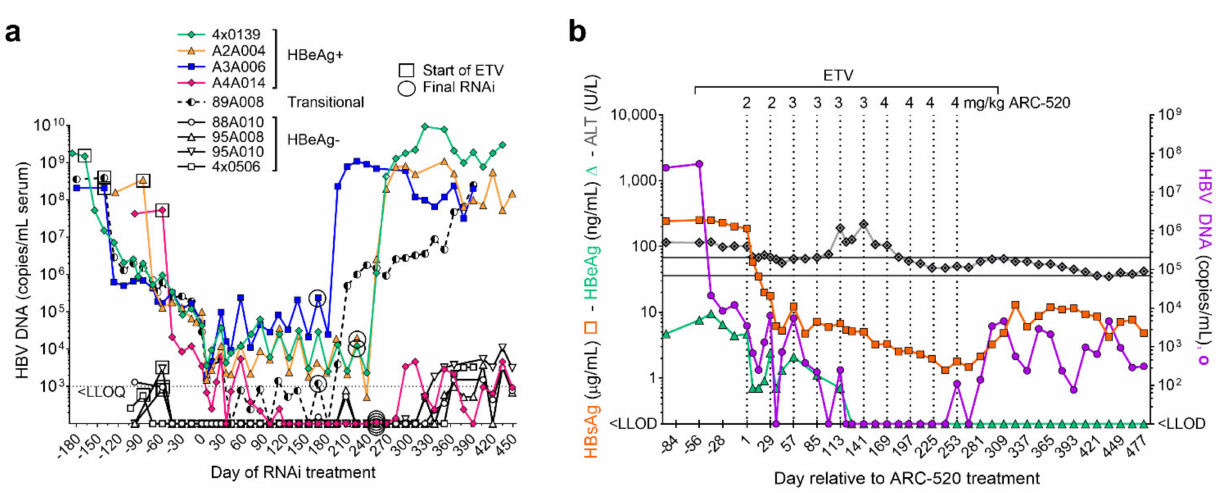
Figure 6. Chimpanzee response to NUC plus ARC-520. ( a ) HBeAg-positive, HBeAg-transitional and HBeAg-negative chimpanzees began daily NUC treatment (box) for a lead-in period of 8 to 24 weeks prior to commencing Q4W dosing with ARC-520, beginning on Day 1. Timing of the final siRNA injection, either ARC-520 or siHBV-75 + EX1 is indicated by a circle. NUC treatment ended approximately one week after the final siRNA injection. Serum HBV DNA levels are shown relative to Day 1 of ARC-520 treatment. ( b ) HBsAg, HBeAg and ALT levels (left y -axis) and serum HBV DNA (right y -axis) are shown for chimpanzee A4A014 prior to treatment, during entecavir lead-in, during entecavir + ARC-520 treatment, and then off all treatment. The normal ALT range for chimpanzees is shown by grey horizontal